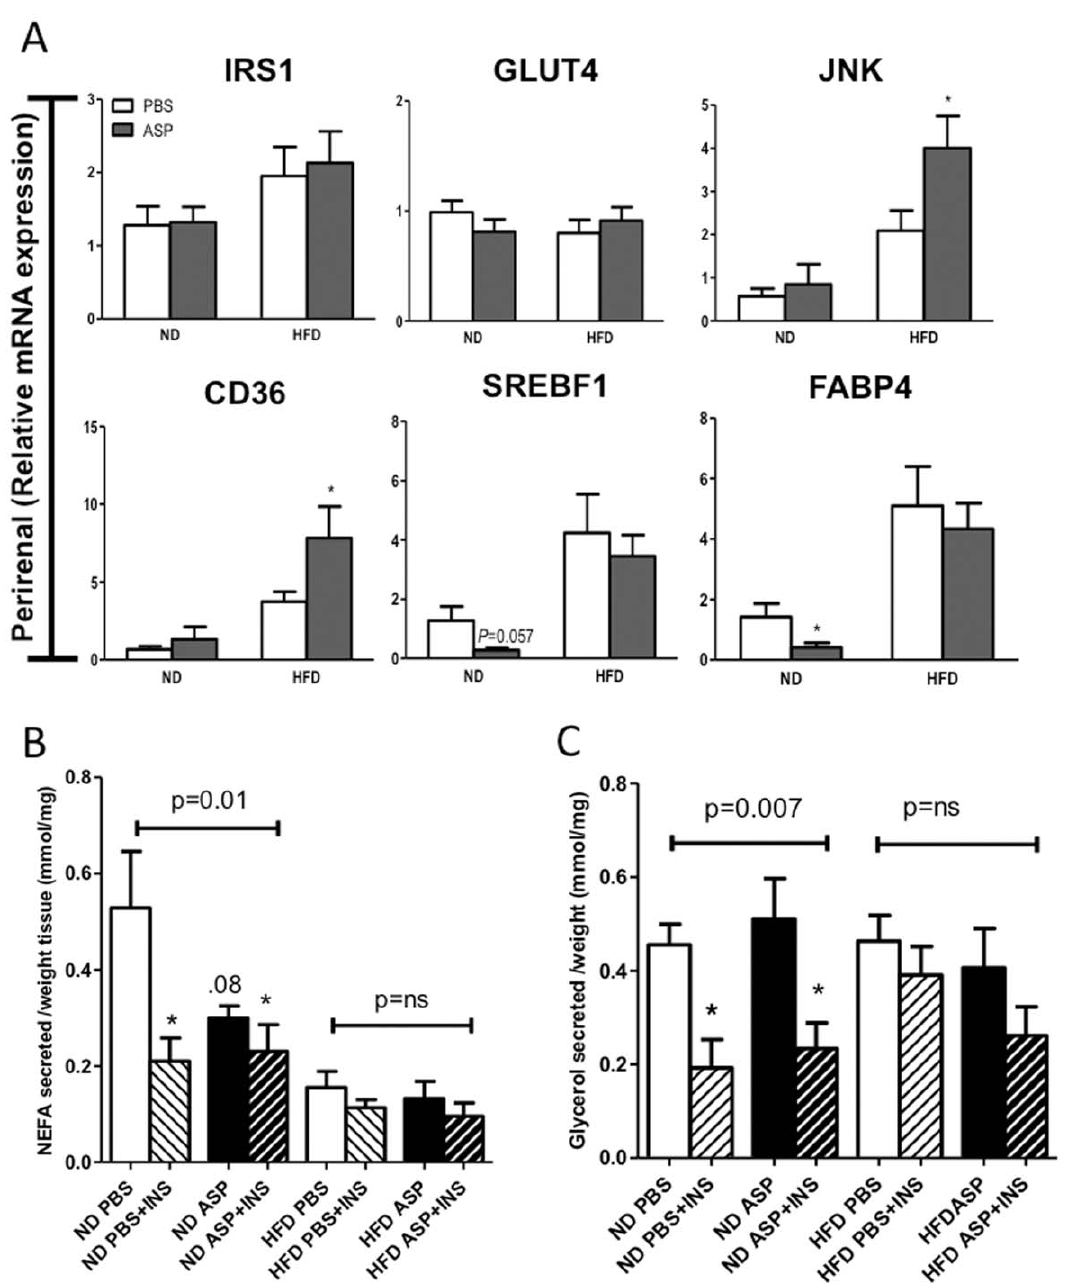
Figure 4. ASP effects on mRNA expression of insulin-related genes, and insulin lipolytic function in adipose tissue. A) Gene expression in perirenal adipose tissue, B and C) Lipolysis measured as non-esterified fatty acid release (B) or glycerol release (C) in perirenal adipose tissue from C3KO mice 6 ASP treatment on ND and HFD, followed by ex vivo stimulation 6 insulin for 3 hours. Results are presented as average 6 SEM (n=5 2 8), where *p , 0.05, **p , 0.01 and ***p ,